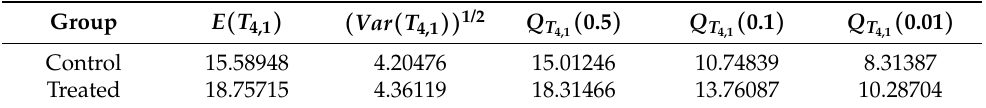
Figure 7. Density functions of time required for the BC297MONp5 tumor to quadruple its initial volume in control and cisplatin treated groups. Table 3. Mean, variance, median, and 0.1 and 0.01 quantiles of T 4,1 in the control and cisplatin treated